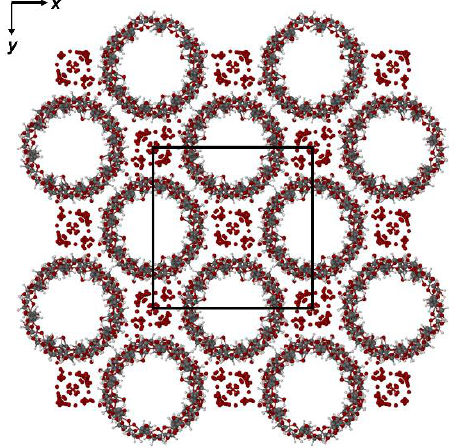
Figure 14. The [001] projection of the structure of the (γ-CD) 3 ·(RSV) 4 ·(H 2 O) 62 complex.